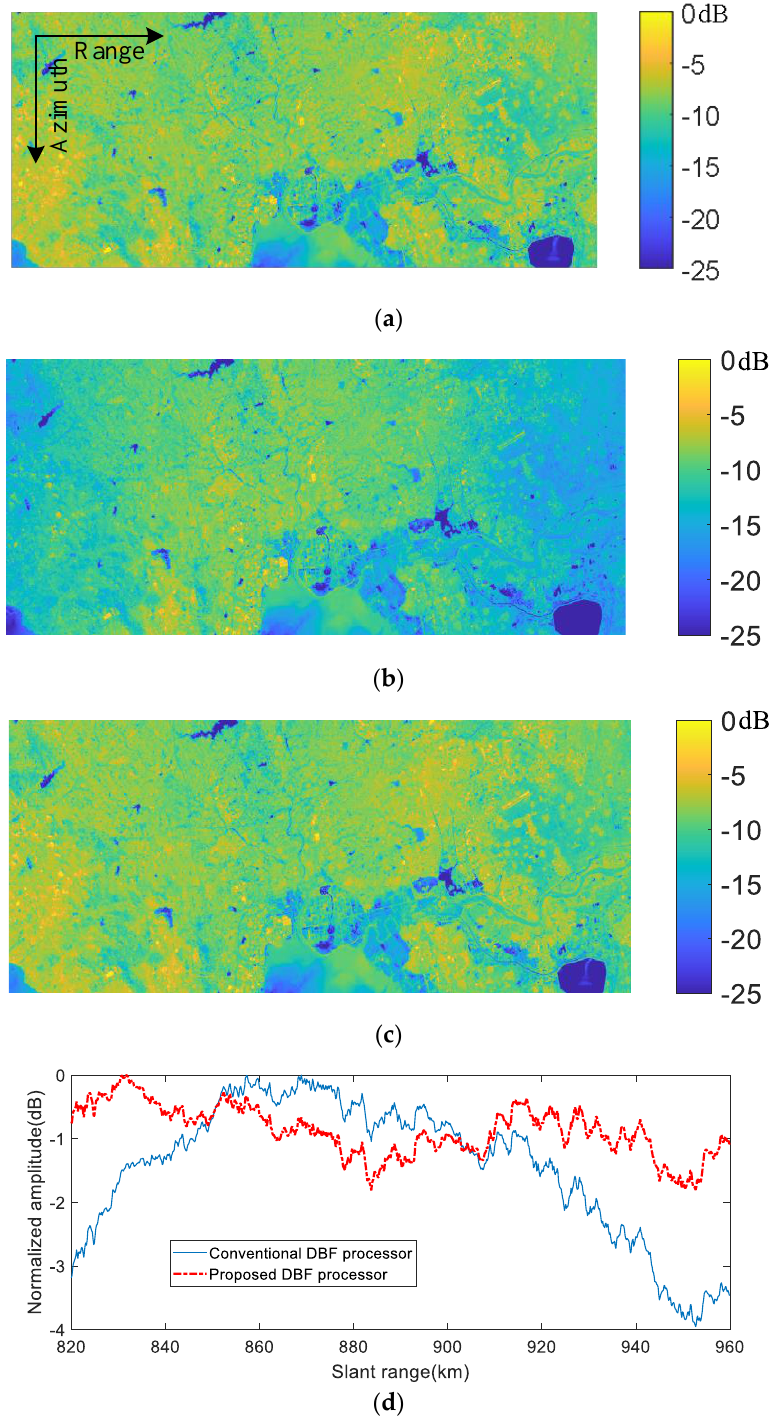
Figure 12. Processing results of the simulated distributed scene by the conventional DBF processor and the proposed DBF processor. ( a ) Focused SAR image for echo simulation. ( b ) Conventional DBF processor processing result. ( c ) Proposed DBF processor processing result. ( d ) Normalized average amplitude comparison.